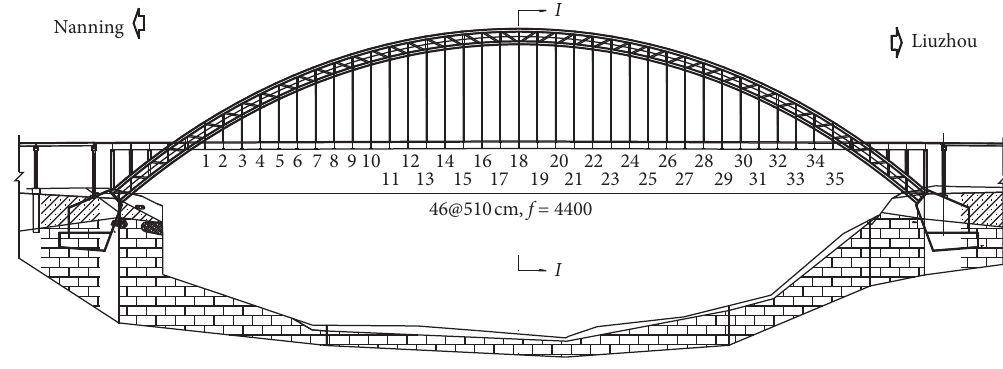
Figure 2: Liujing-Yujiang